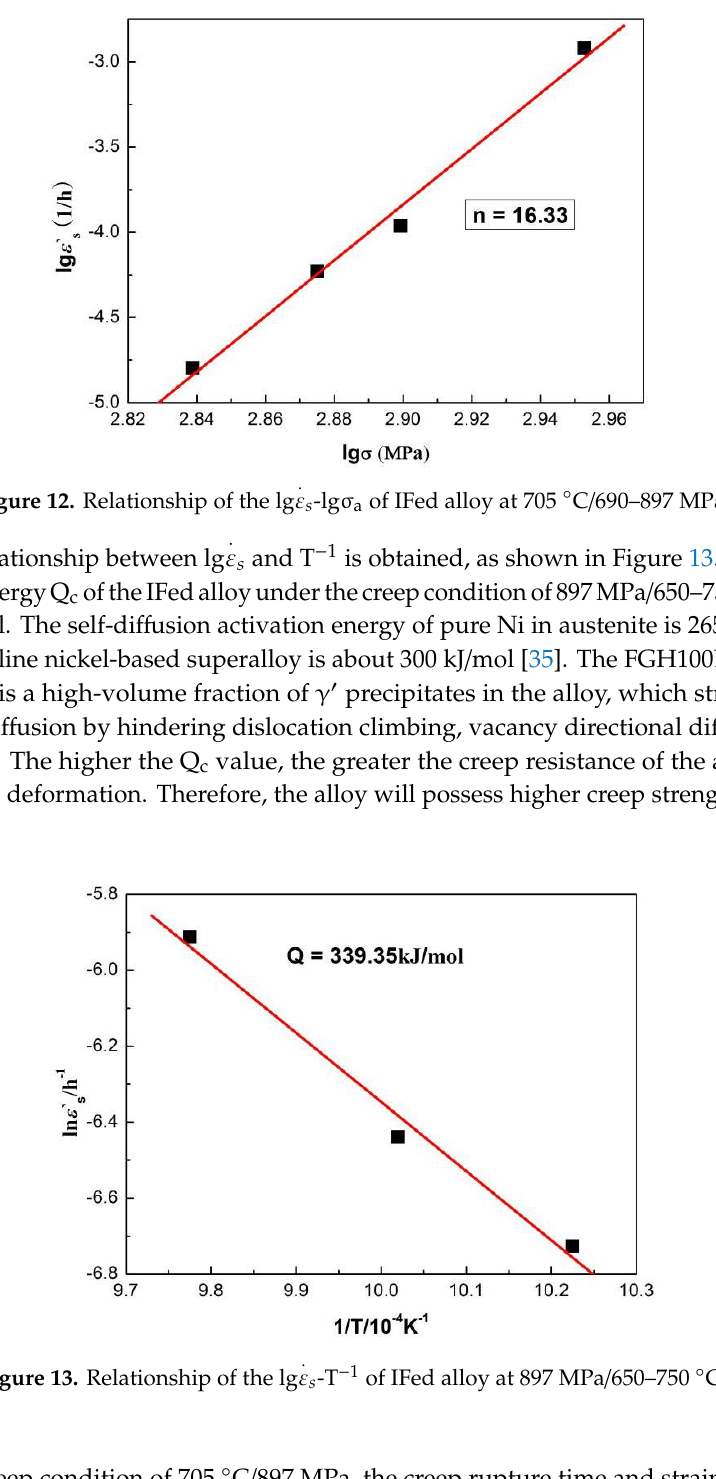
Figure 13. Relationship of the lg s -T −1 of IFed alloy at 897 MPa/650 – 750 °C.